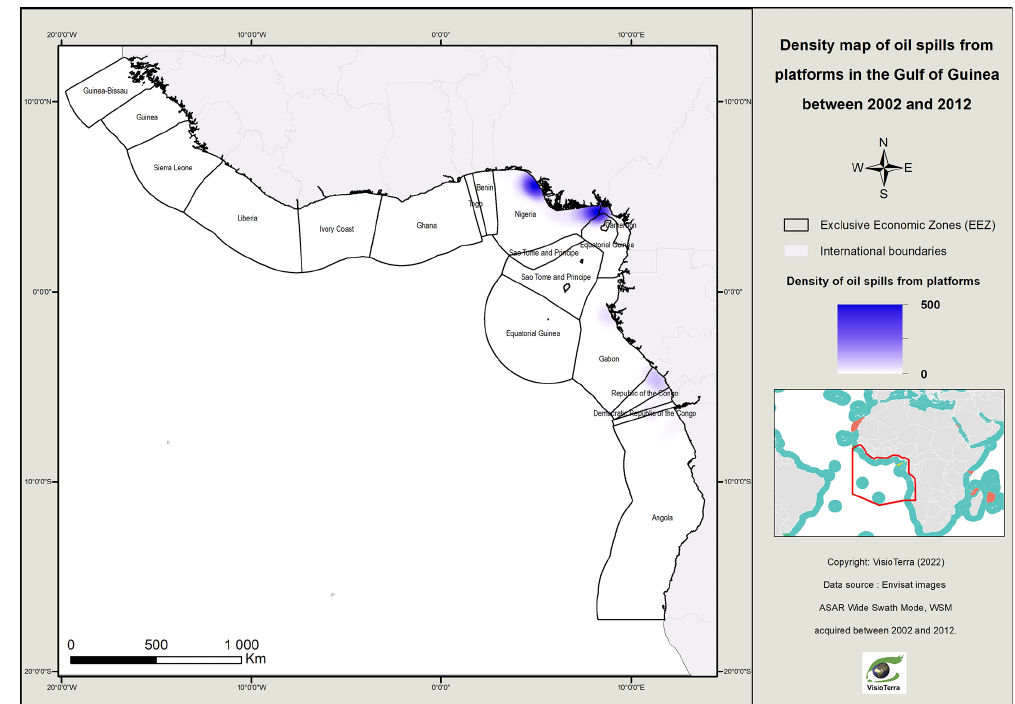
Figure 14. Density map of oil spills from platforms in the Gulf of Guinea between 2002 and 2012.